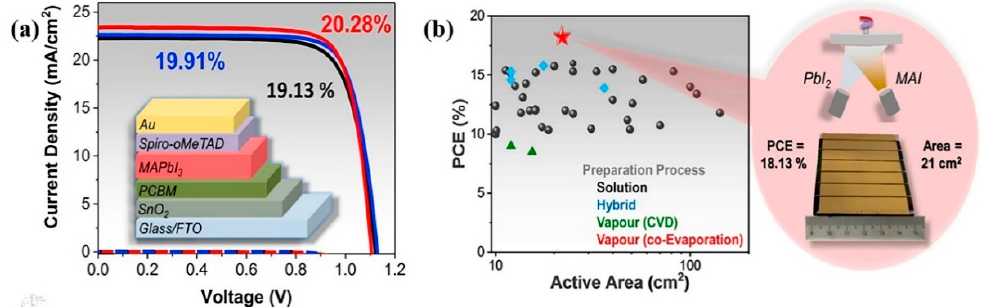
Figure 14. Thermal co-evaporation of MAPbI 3 thin films. ( a ) Champion PSC J–V curves in backward scanning mode. ( b ) PCE of perovskite materials with an active area larger than 10 cm 2 fabricated using different methods [144]. Copyright 2020 Elsevier.